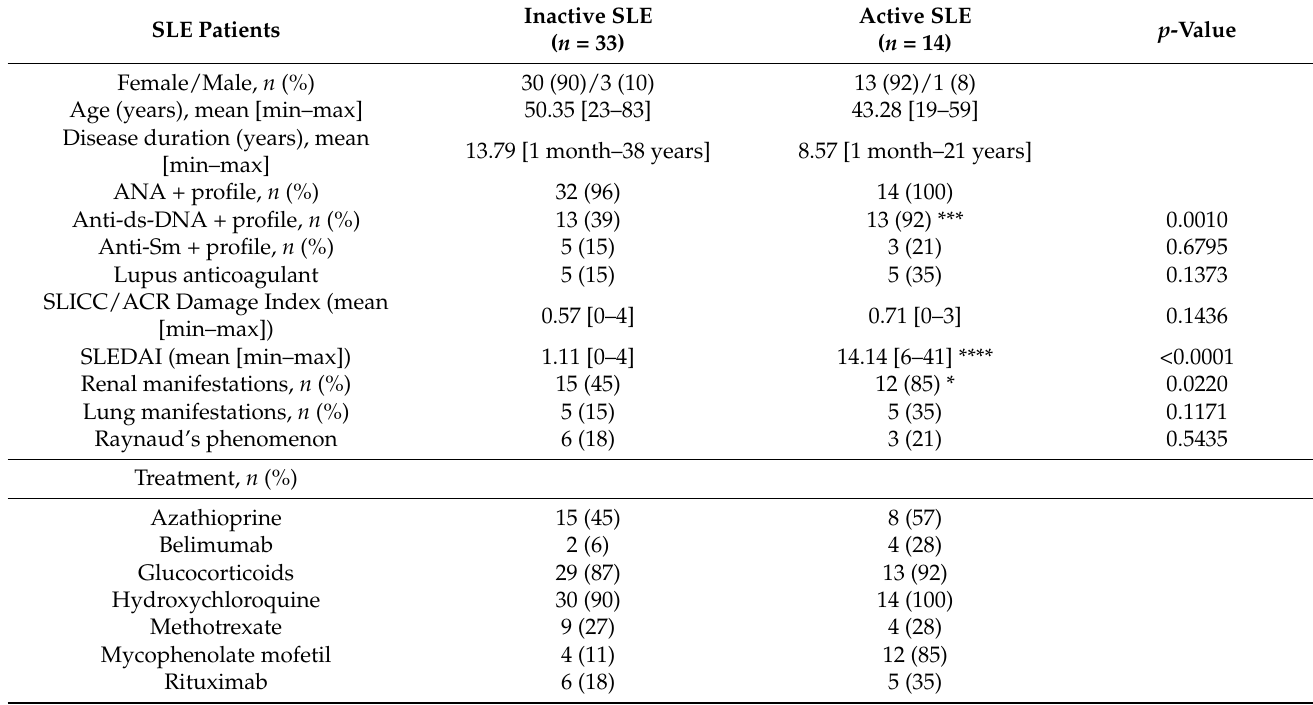
Table 1. Clinical features of SLE patients participating in the study performed to analyze the expres- sion of PSGL-1 in